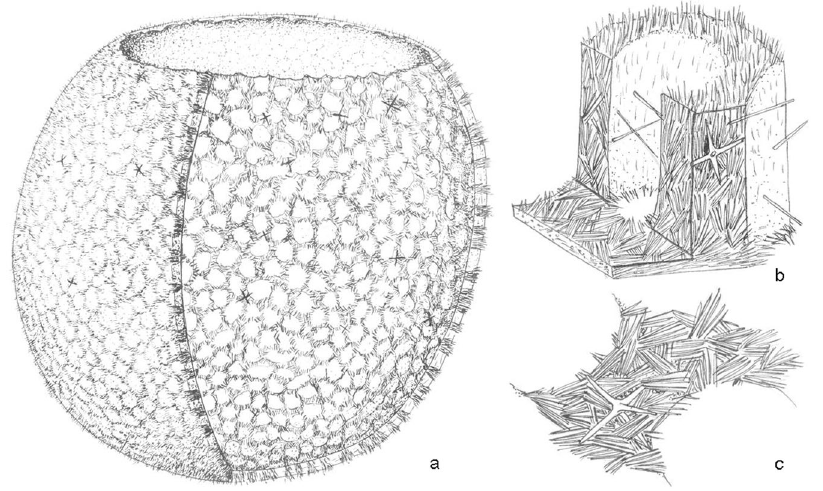
Figure 1. Reconstruction of Conciliospongia anjiensis gen. et sp. nov. ( a ) Overall cut-away view showing inner part of wall (right half) and outer surface (left half), with gaps in skeletal wall probably representing sites of choanocyte chambers, bounded by soft tissue walls; ( b ) three-dimensional cut-away reconstruction through wall thickness, illustrating tufts of fine monaxon spicules (up to 0.3 mm long), becoming more perpendicular to wall